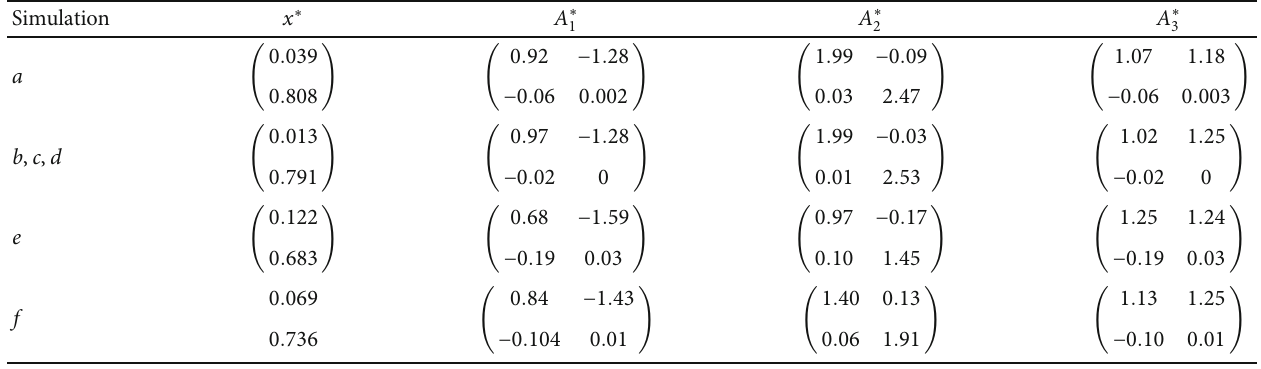
Table 3: Experiment 1: solution of problem (9), given by Algorithm 3.